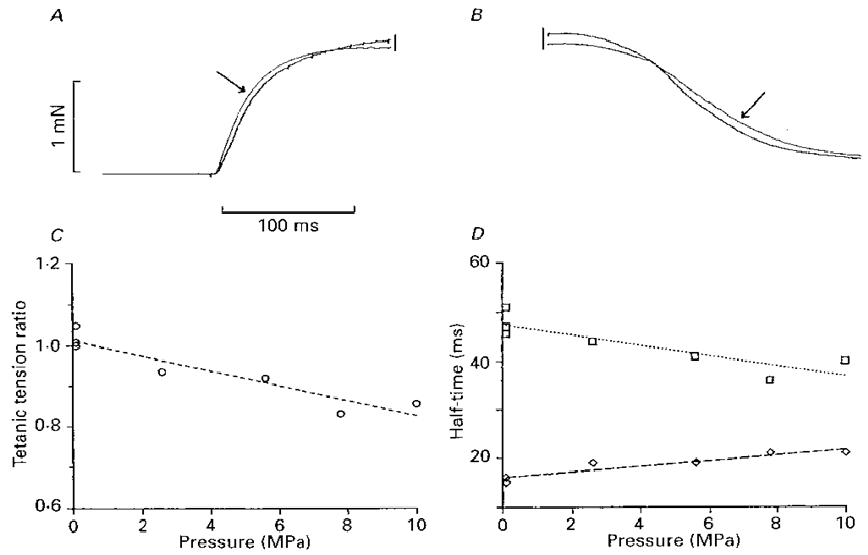
Figure 10. ( A , B ) Tetanic contraction at 6.5 MPa (arrowed) superimposed on that at atm pressure: A and B show the rising and falling phases. ( C , D ) Pressure dependence of tension ( C ) and half-time to tension rise (□) and half - time to tension relaxation (◊) (adapted from [18]).